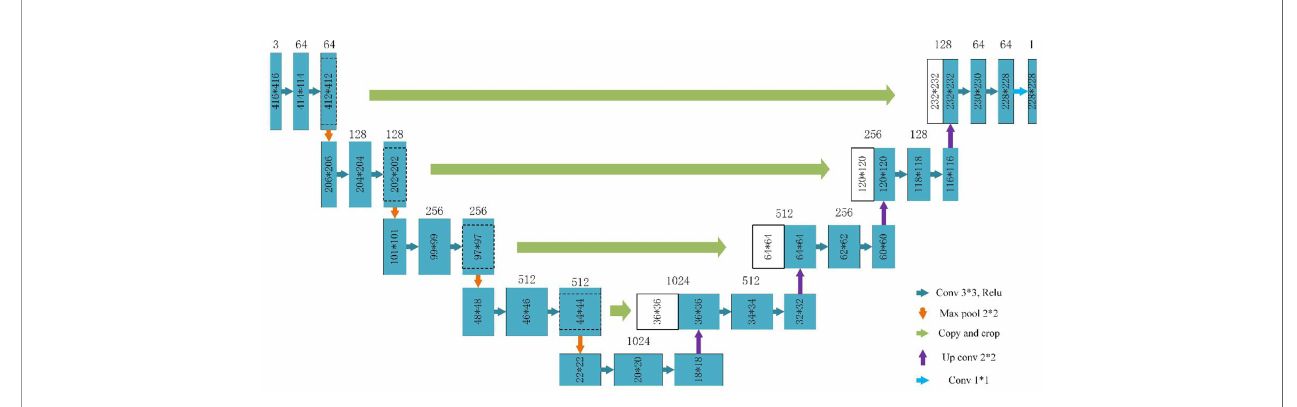
FIGURE 4 | U-Net architecture based